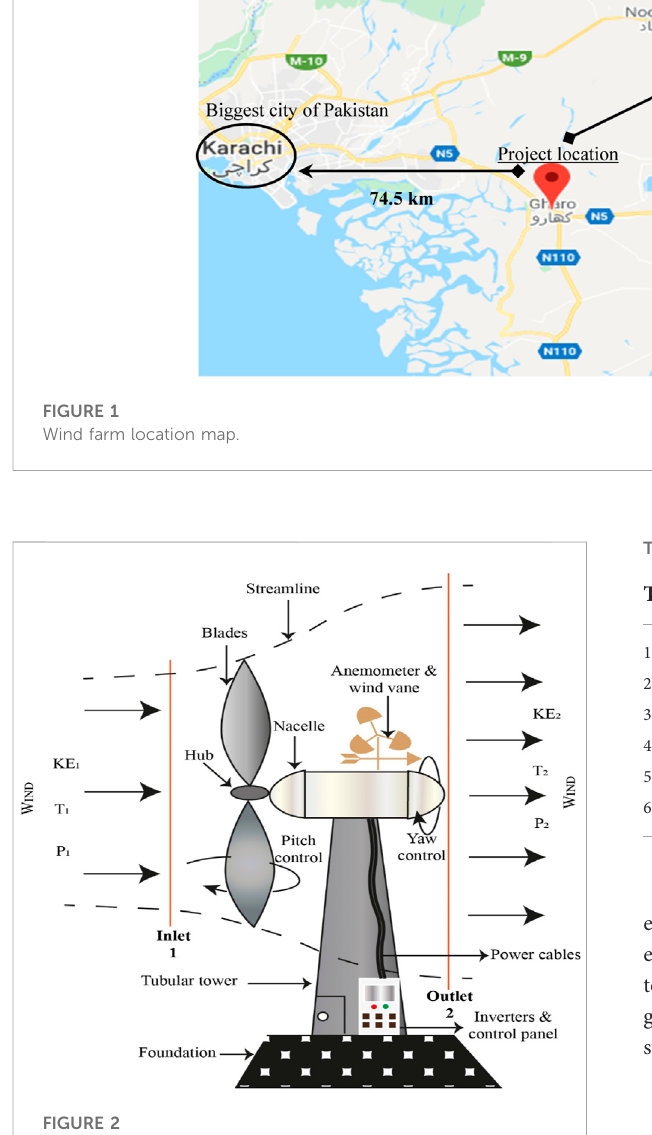
FIGURE 2 Side view of the horizontal axis three-blade wind turbine.